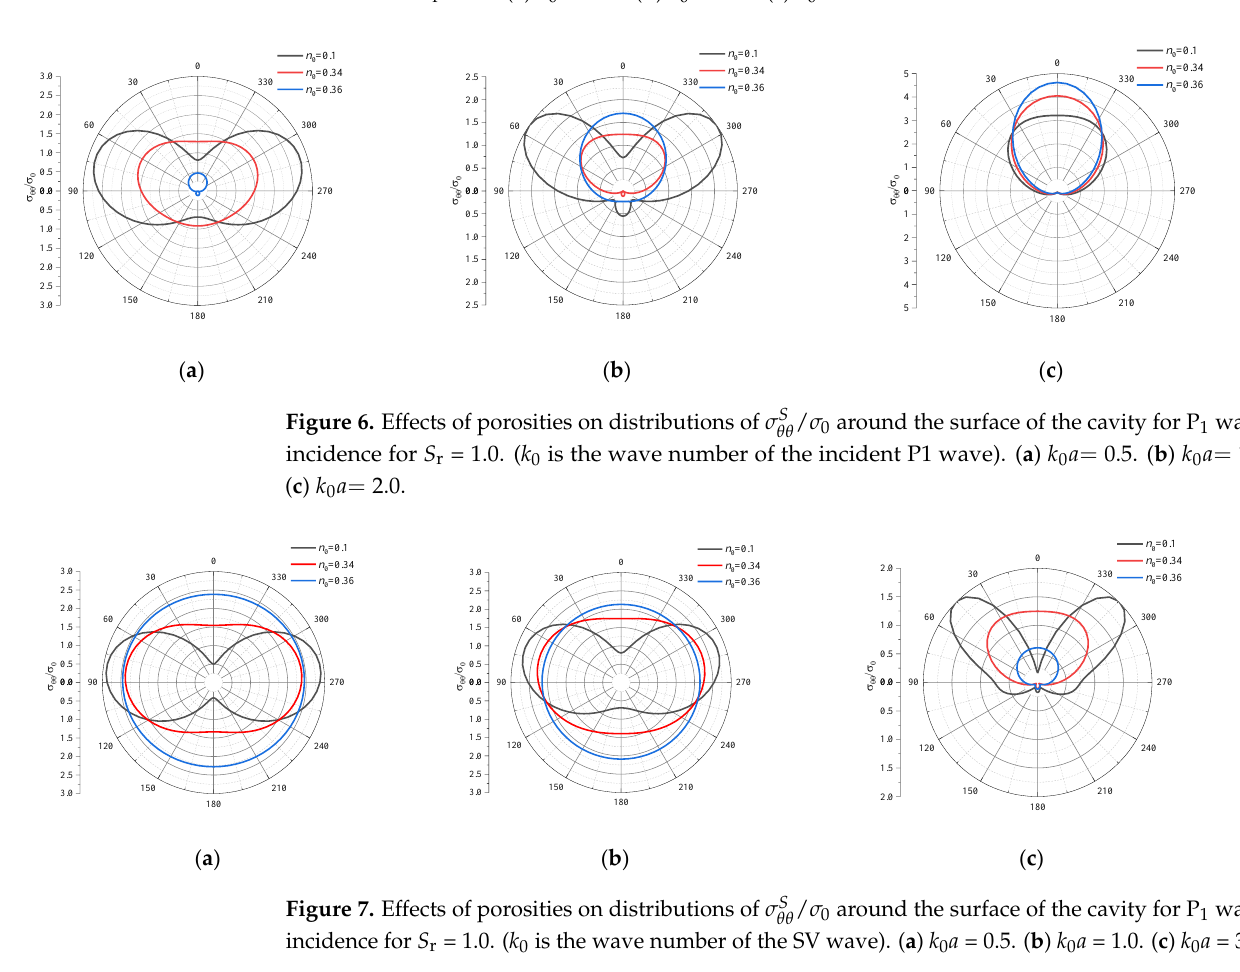
Figure 5. Effects of porosities on distributions of σ S incidence for S r = 0.6. ( a ) k 0 a = 0.5. ( b ) k 0 a = 1.0. ( c ) k 0 a = 2.0.